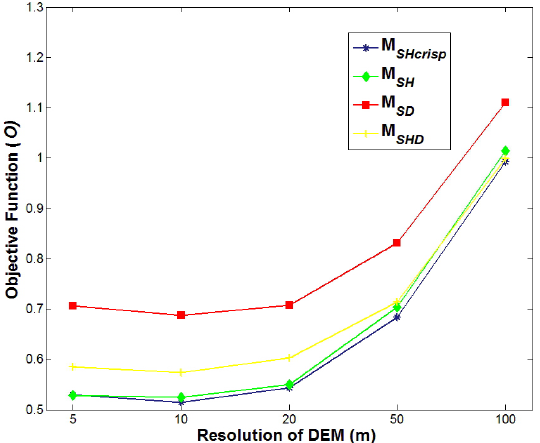
Fig. 8. Performance of different classification models for different DEM